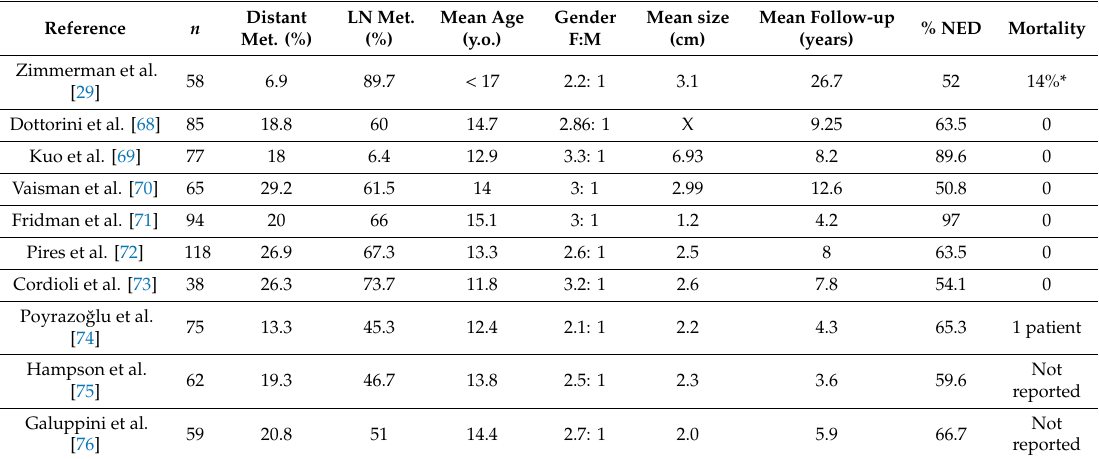
Table 1. Clinical pathological features of pediatric